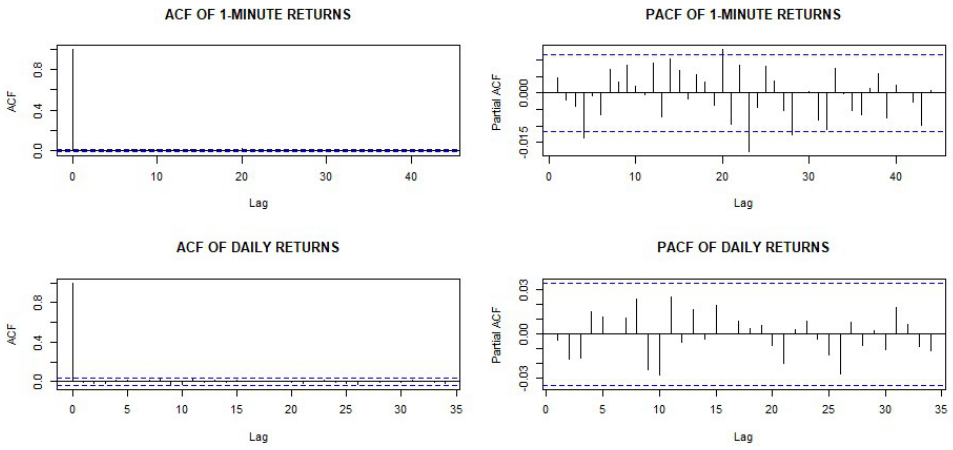
Figure 3. ACF and PACF plots for intraday and daily return series. PACF: Partial Auto Correlation Function.